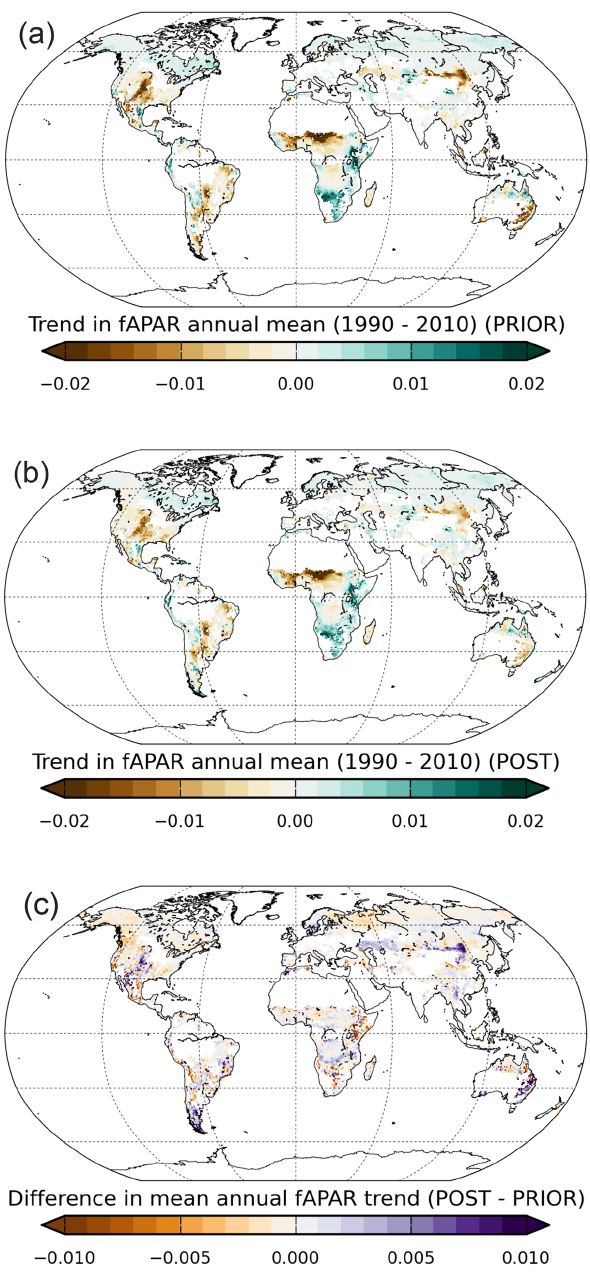
Figure 9. Linear trend (yr − 1 ) in the annual mean of the simulated normalised fAPAR for the 1990–2010 period: (a) prior simulation; (b) posterior simulation; (c) difference between the prior and poste- rior (posterior –